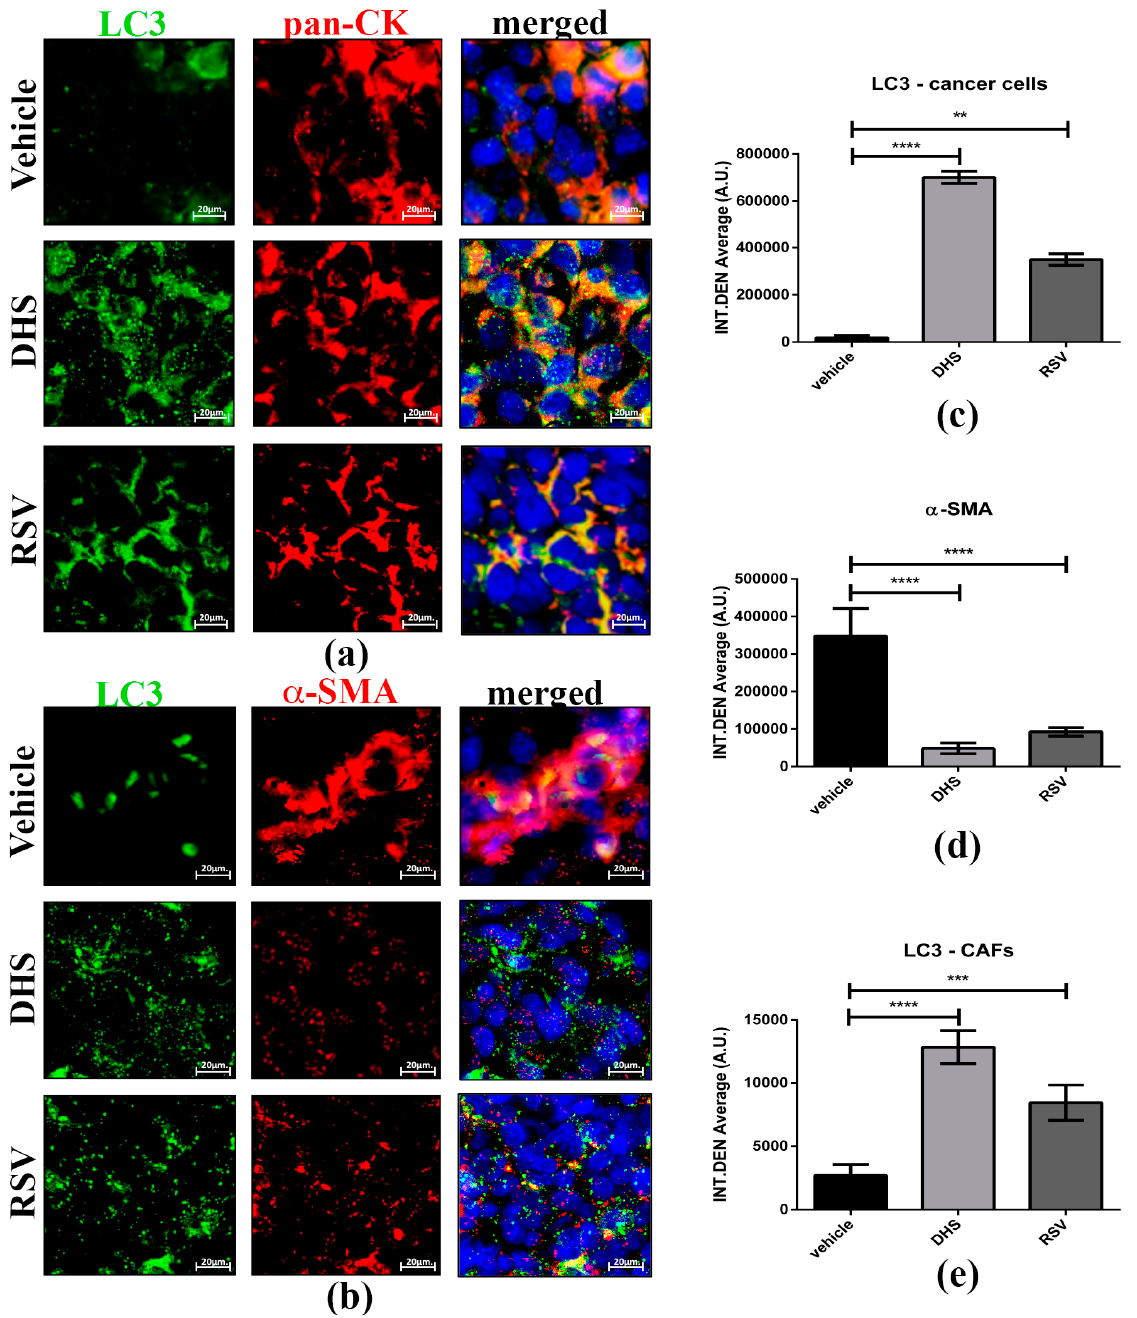
Figure 7. ( a , b ) Representative images of LC3 (green)/pan-cytokeratin (red) ( a ) and LC3 (green)/ α - SMA (red); ( b ) co-staining for vehicle, DHS-, and RSV-treated tumour masses (scale bars = 20 μ m; 63 × magnification), and relative quantification of LC3 in pan-CK-positive epithelial cancer cells ( c ), while α -SMA ( d ) and LC3 levels were quantified in CAF population ( e ) fluorescent signals (** p < 0.01; *** p < 0.001; **** p <